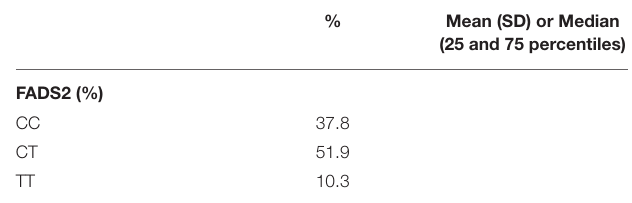
TABLE 1 | Characteristics of the study participants.